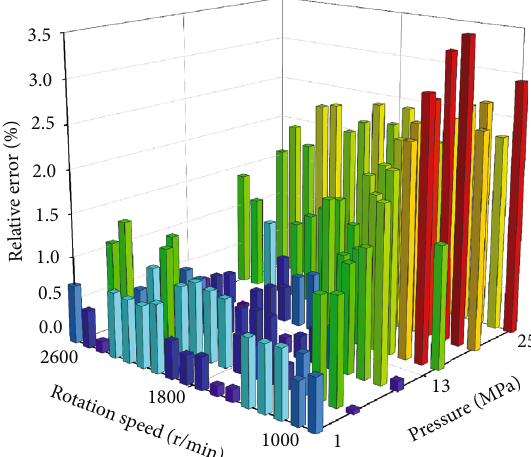
Figure 12: The relative error between simulation results and experiment results.